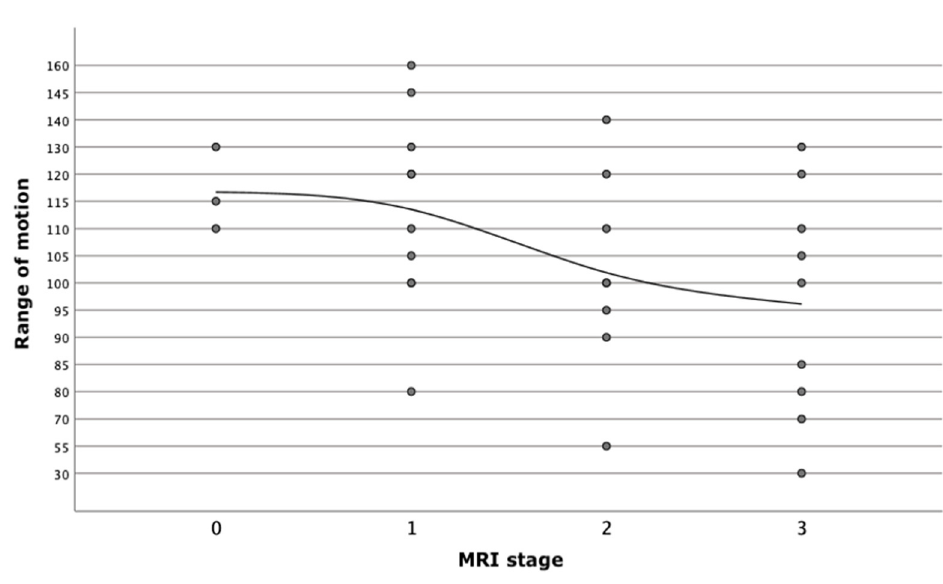
Figure 1. Correlation between MRI stage of cartilage lesion and restriction of range of motion